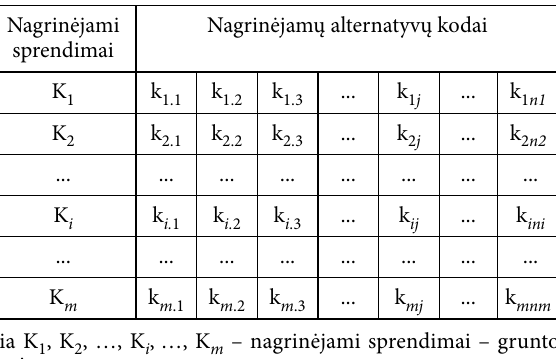
Table 1. Alternative codes for executing earth works and quantitative information provided by them